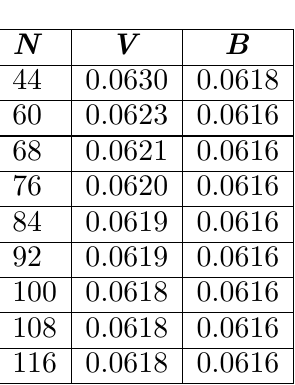
Table 1. Velocity and induced mag- netic field values from the inverse so- lution at the point ( − 1 , 0), M = π 10 , β = , α = 0 . 2 , c = 0 . 3 . 2